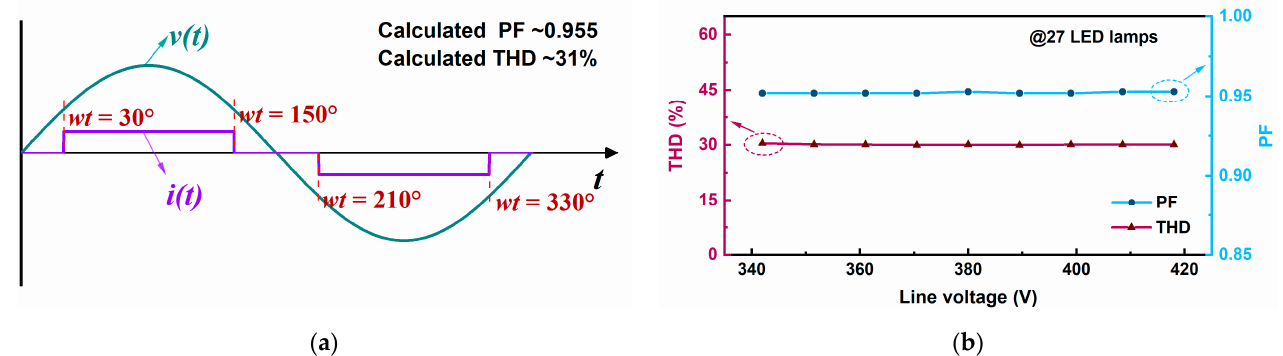
Figure 8. ( a ) AC voltage waveform v ( t ) and current waveform i ( t ) in the linear multi-string LED driving scheme. ( b ) PF and THD of 27 GaN LED lamps under 380 V ± 10% line voltage.